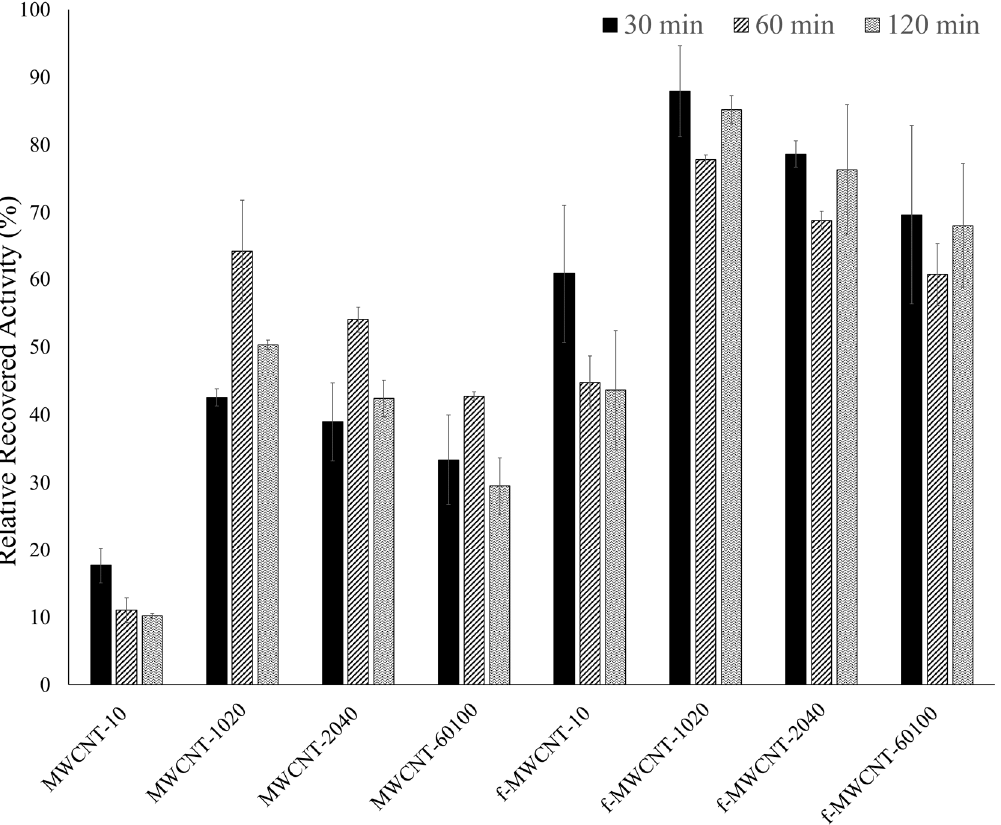
Figure 3. Effect of immobilization time and diameter of multi-walled carbon nanotubes (MWCNTs) on the relative recovered activity ( RRA ). Immobilization of 0.086 mg/mL of L-asparaginase (ASNase) onto 2 mg of pristine multi-walled carbon nanotubes (MWCNTs) and functionalized MWCNTs (f-MWCNTs) at pH 8. Error bars correspond to the standard deviation between replicates.